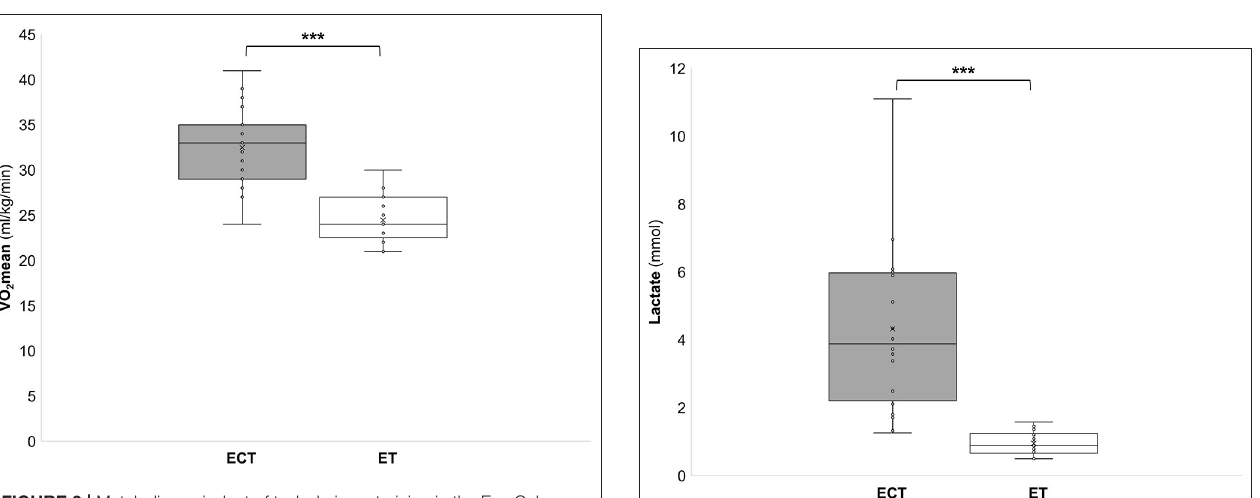
FIGURE 3 | Metabolic equivalent of task during a training in the ExerCube (ECT) , and a moderate endurance training (ET) . *** p < 0.001. TABLE 3 | Intrinsic motivation during the training in the ExerCube and the endurance training. Subscales ECT ET P -Values Interest/Enjoyment